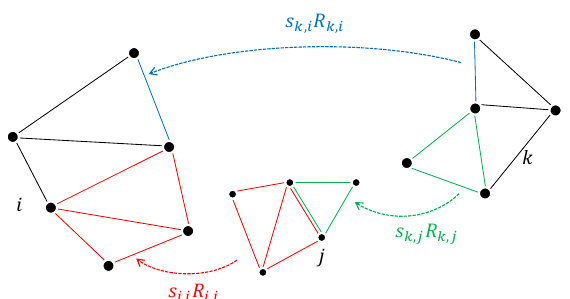
Figure 2. Sketch of a group of three models 𝑖 , 𝑗 and 𝑘 . Dots indicate cameras. Bases shared by different models are marked by colour. Relative rotations and scales between the models are indicated by arrows.